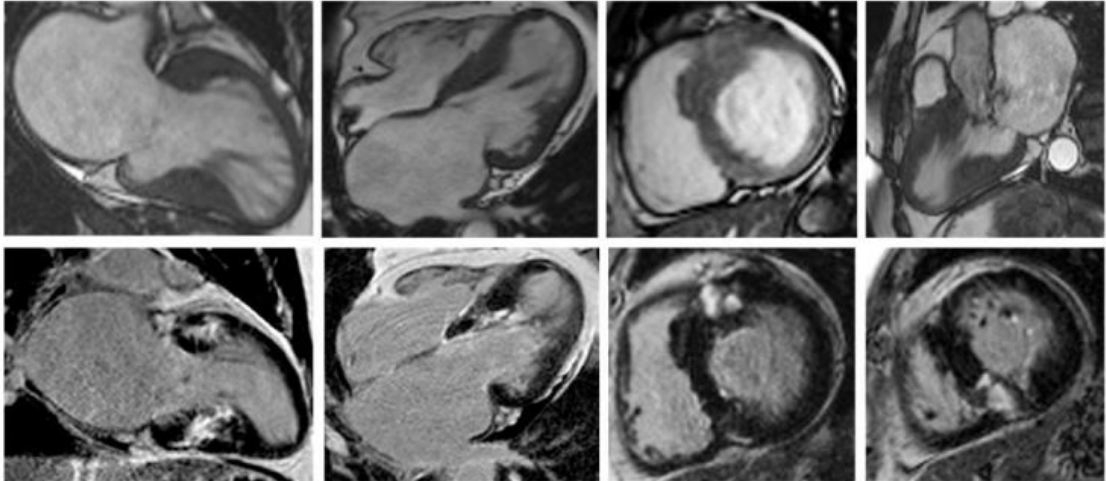
Figure 2. Contrast-enhanced CMR in a 50-year-old male patient with hypertrophic cardiomyopathy (from the own collection of the authors). ( Upper row ): b-SSFP cine images in two chambers, four chambers, short axis and three chambers, respectively. There is asymmetrical LV hypertrophy, with a maximum thickness of 20 mm at the basal anterior wall. The LV is not dilated and the LVEF is within normal limits (59%). There is systolic anterior motion of the mitral valve, resulting in acceleration of the systolic flow in the LV outflow tract. ( Lower row ): LGE imaging shows patchy myocardial fibrosis of the hypertrophied segments. Abbreviations: b-SSFP, balanced steady-state free precession; CMR, cardiac magnetic resonance imaging; LVEF, left ventricle ejection fraction; LGE, late gadolinium enhancement; LV, left